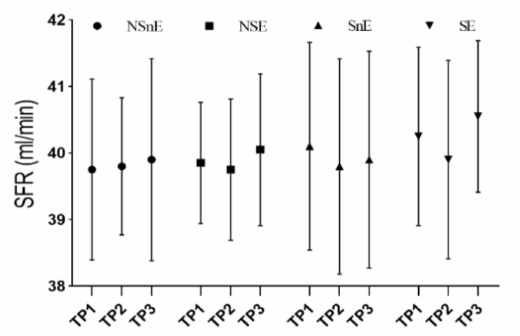
Figure 3. Change in salivary flow rate for the four groups, and for each time point. TP1 = time point from Pre-test, TP2 = time point immediately after the test, TP3 = time point one hour after the test; NSnE = non-smokers that did not exercise; NSE = non-smokers that did exercise; SnE = smokers that did not exercise; SE = smokers that did exercise; SFR= Salivary Flow